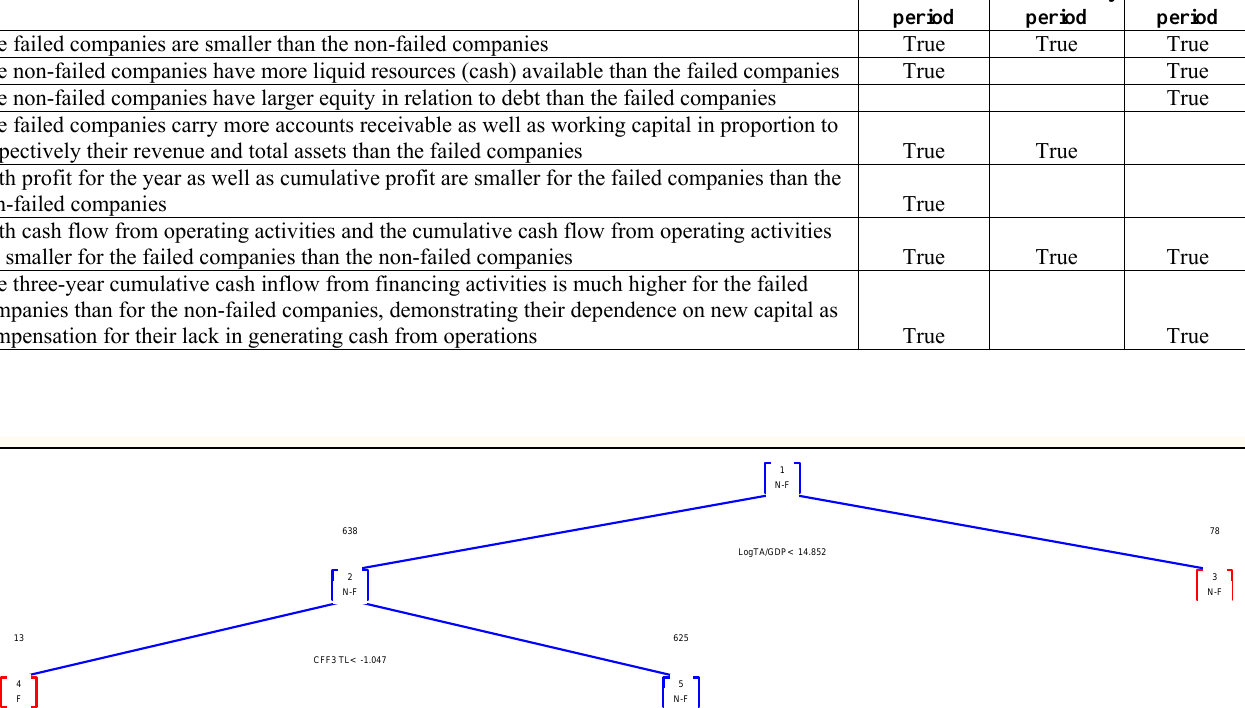
Table 5: Generalised characteristics of failed versus non-failed companies General characteristic